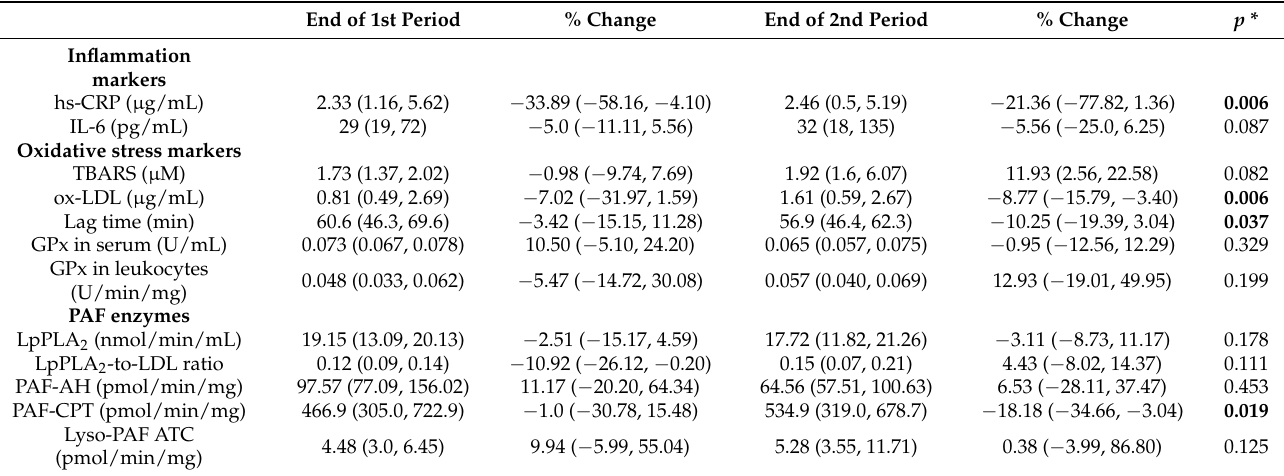
Table 2. Inflammation markers, oxidative stress markers, and enzymes of PAF metabolism of the participants on the conventional fish (CF) diet by